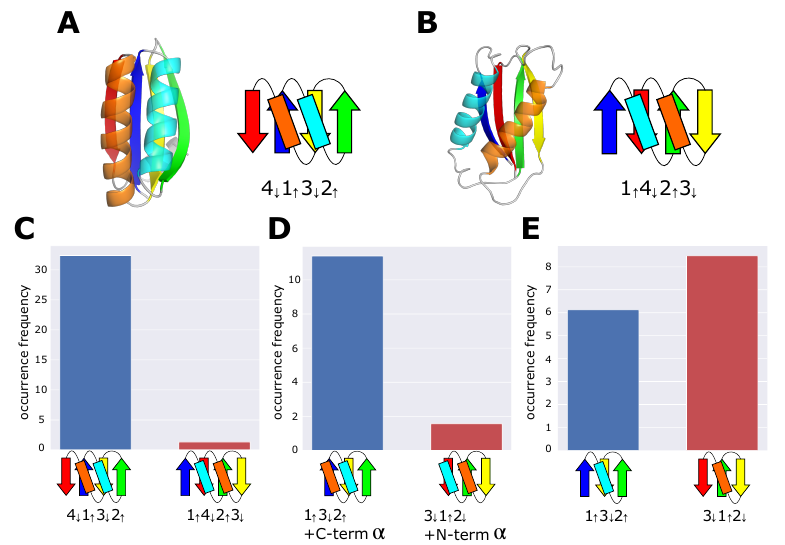
Figure 1. Topology and occurrence frequency of the ferredoxin fold and the reverse ferredoxin fold. ( A ) An example structure (a microcompartment protein, PDB ID: 4QIV) and the topology 4 ↓ 1 ↑ 3 ↓ 2 ↑ of the ferredoxin fold. ( B ) An example structure (the catalytic core of human DNA polymerase kappa, PDB ID: 1T94) and the topology 1 ↑ 4 ↓ 2 ↑ 3 ↓ of the reverse ferredoxin fold. ( C ) Occurrence frequency of the ferredoxin topology 4 ↓ 1 ↑ 3 ↓ 2 ↑ and the reverse ferredoxin topology 1 ↑ 4 ↓ 2 ↑ 3 ↓ . ( D ) Occurrence frequency of the topology 1 ↑ 3 ↓ 2 ↑ + C-term α and the topology 3 ↓ 1 ↑ 2 ↓ + N-term α . ( E ) Occurrence frequency of the topology 1 ↑ 3 ↓ 2 ↑ and the topology 3 ↓ 1 ↑ 2 ↓ . In ( C – E ), the dataset of the 99% sequence identity representatives derived from ECOD was used. Chains are colored from blue (N-terminus) to red (C-terminus). In the topology diagram, β -strands are represented with arrows and α -helices are